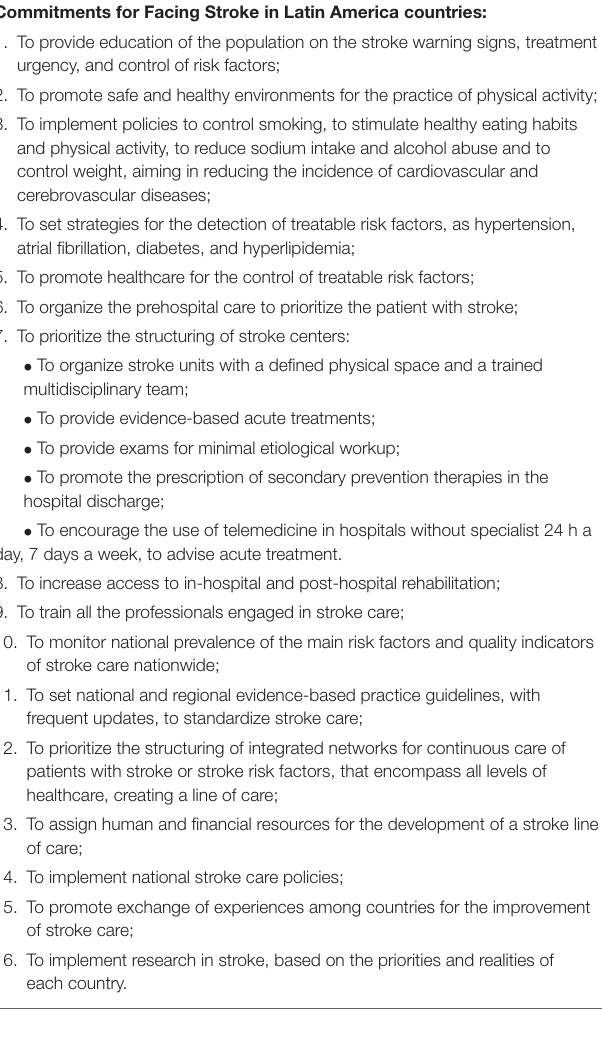
TABLE 1 | Declaration of